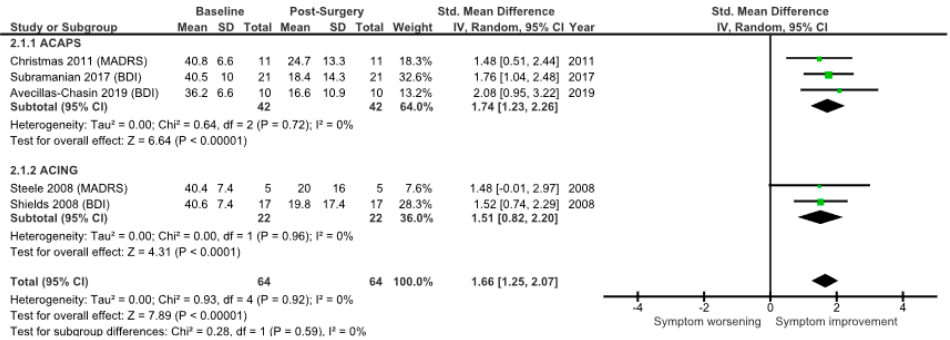
Figure 4. Standardised mean difference in depression scores pre- and post-ablative surgery for ACAPS and ACING. Only patients where individual patient data are available are included. The